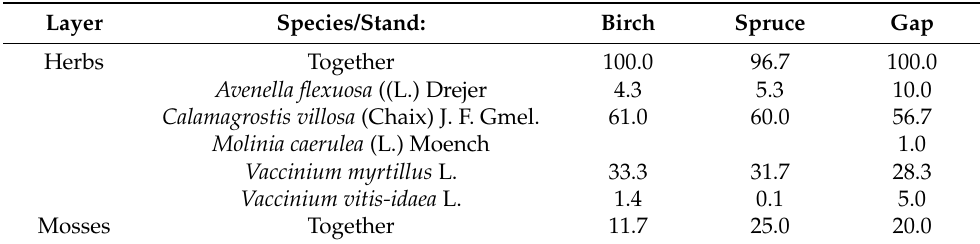
Table 1. Average abundance of the dominant ground vegetation species according to treatment in